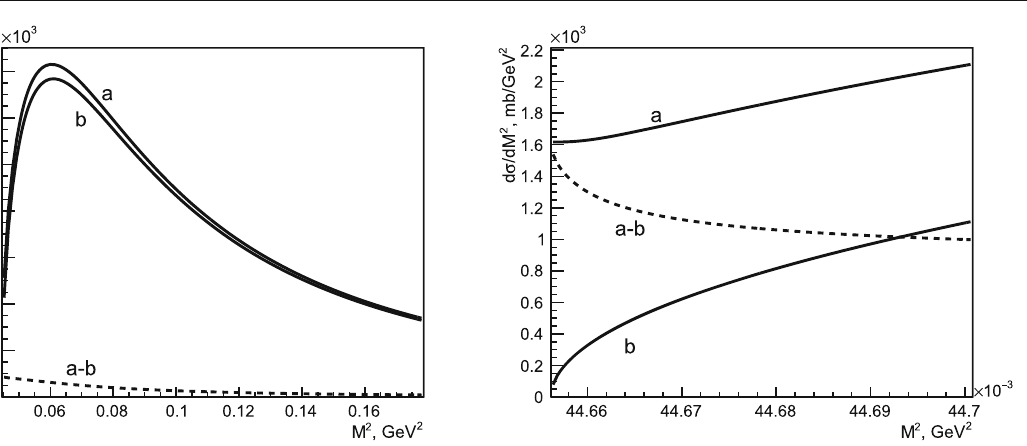
Fig. 3 The distribution of masses of muon pairs produced in ultrape- dashed line. The region of small masses is shown in the right-hand side √ s nn =5.02 TeV with ( a ) and without ripheral collisions at LHC energy at the enlarged scale. Note the factor 10 − 3 at the abscissa ( b ) account of the SGS-factor. Their difference ( a , b ) is shown by the